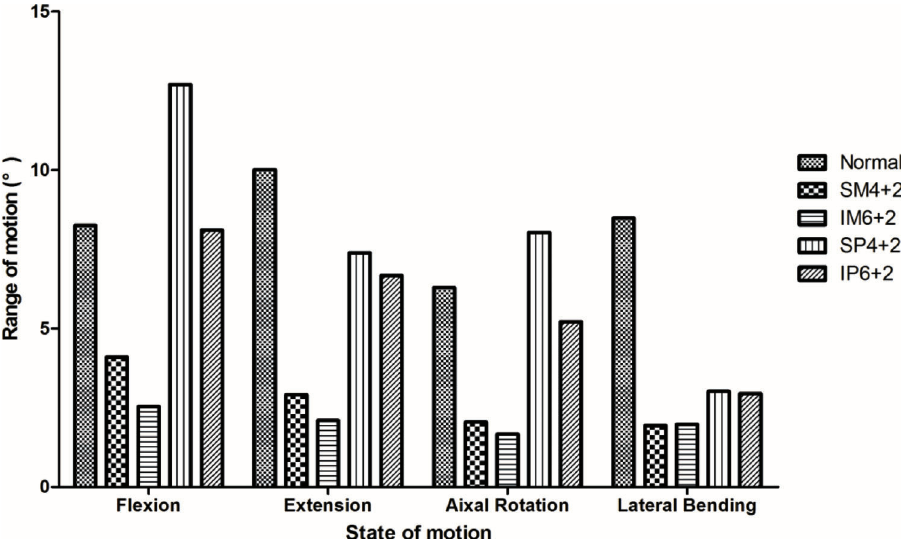
Figure 1 - Range of motion (ROM). SM4 + 2/SP4 + 2 : short-segment monoaxial/polyaxial pedicle screw fixation; IM6 + 2/IP6 + 2 : intermediate monoaxial/polyaxial pedicle screw